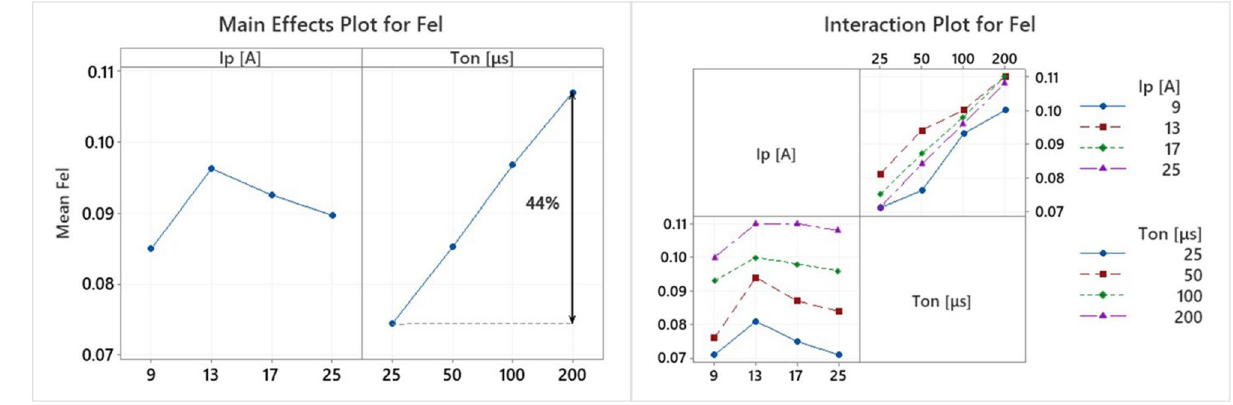
Figure 16. Main effects plot and interaction plot of F el .